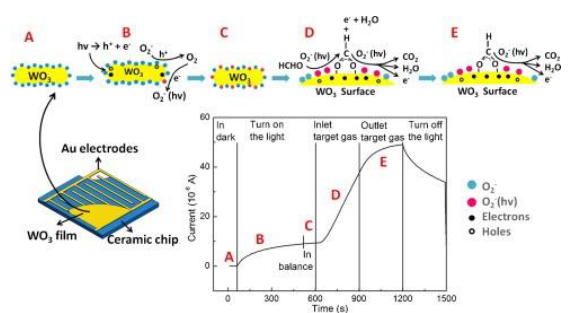
( b ) Figure 20. ( a ) Schematic illustration of the ZnO@ZIF-8 nanorod sensor with selectivity for different VOCs molecule; ( b ) gas selectivity to 100 ppm of different VOCs at working temperature of 300 °C [16].